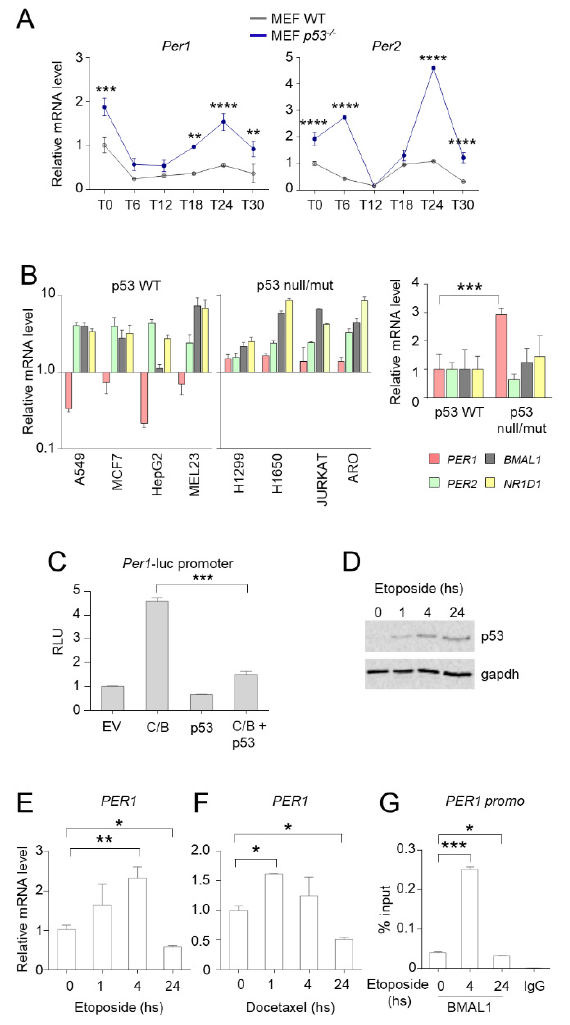
Figure 3. Control of PER1 expression by p53. ( A ) Circadian expression of Per1 and Per2 in MEFs WT and p53 − / − . Real-time PCR analysis was performed from RNAs prepared at the indicated times after serum shock synchronization. T0, unsynchronized cells. Bars represent average ± SD (n = 2). (**) p < 0.01, (***) p < 0.001, (****) p < 0.0001. ( B ) Q-PCR analysis of PER1 , PER2 , BMAL1 and NR1D1 from RNA samples prepared from different human cancer cell lines. Espression value in non-tumoral HEK-293 cells was set to 1. Bars represent average ± SD (n = 3). Right, average levels of expression of the same genes in p53 wild-type cell lines (A549, MCF7, HepG2, MEL23) versus p53 null/mut cell lines (H1299, H1650, JURKAT, ARO). Bars represent average ± SD. (***) p < 0.001. ( C ) the indicated plasmids (C/B = Clock/Bmal1; ev = empty vector). Levels of expression are relative